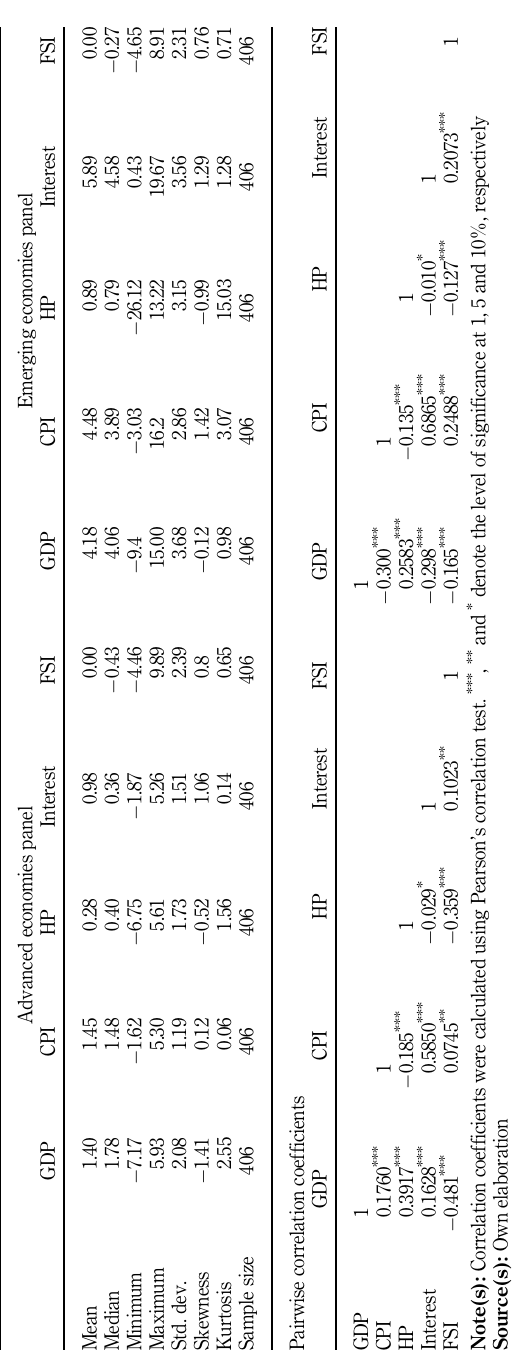
Table 1. Descriptive